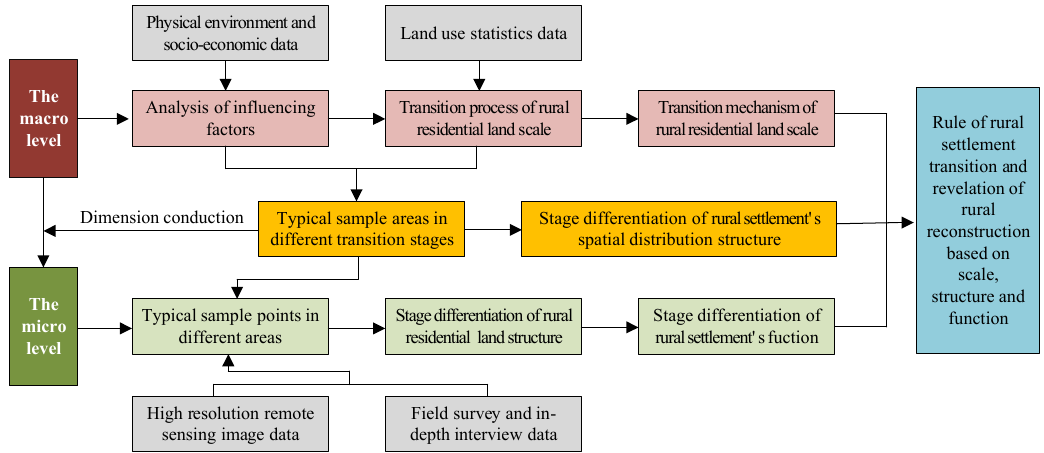
Figure 2. Research framework of rural residential land transition.